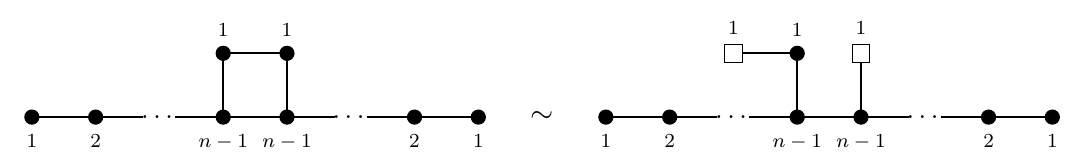
Figure 2 . The 3d mirror of SU( n ) with N f = 2 n − 1 . All nodes are unitary and therefore we should ungauge an overall U(1) . We choose to ungauge one of the abelian nodes above. This mirror quiver was obtained in [47] and can be derived e.g. by starting from the 3d mirror of SU( n ) with 2 n flavors and turning on a SU(2 n − 1) -preserving Fayet-Iliopoulos (FI) deformation.